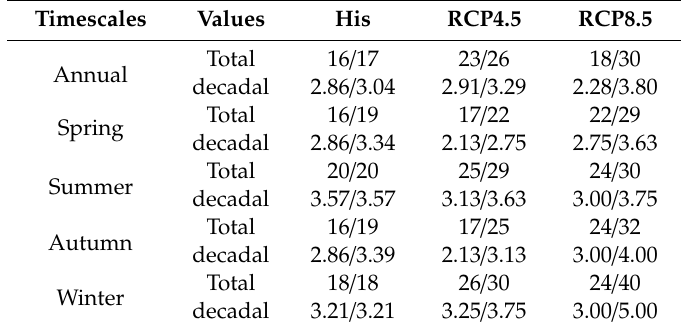
Table 6. Annual and seasonal total extreme drought frequency and their average decadal extreme drought frequency in the whole historical period (1960–2015) and the future (2020–2099).